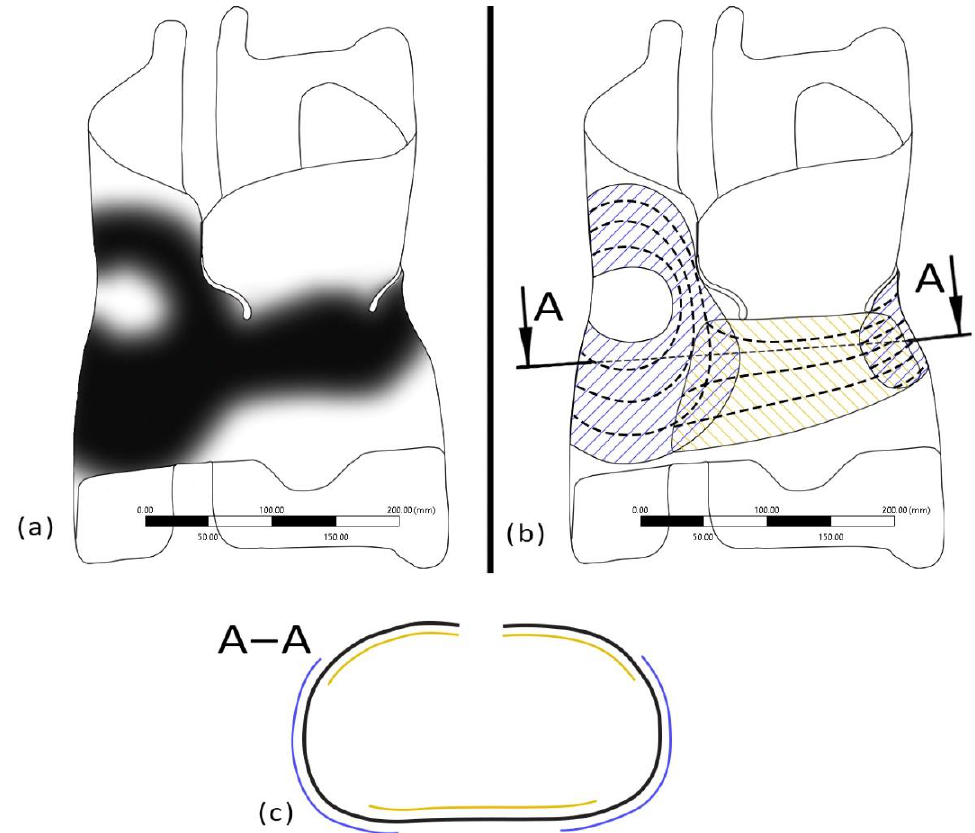
Figure 11. Boston brace: ( a ) area of the brace’s structure exerting the greatest effort, performing a corrective role (dark colour), and the remaining area, playing an auxiliary role (light colour), ( b ) stiffening by integrating its surface with thin composite layers made of polypropylene reinforced with glass or carbon fibres that are arranged by the principal stress trajectories, ( c ) a cross-section showing the brace overlay positions; dashed lines—orientation of reinforcement fibres.